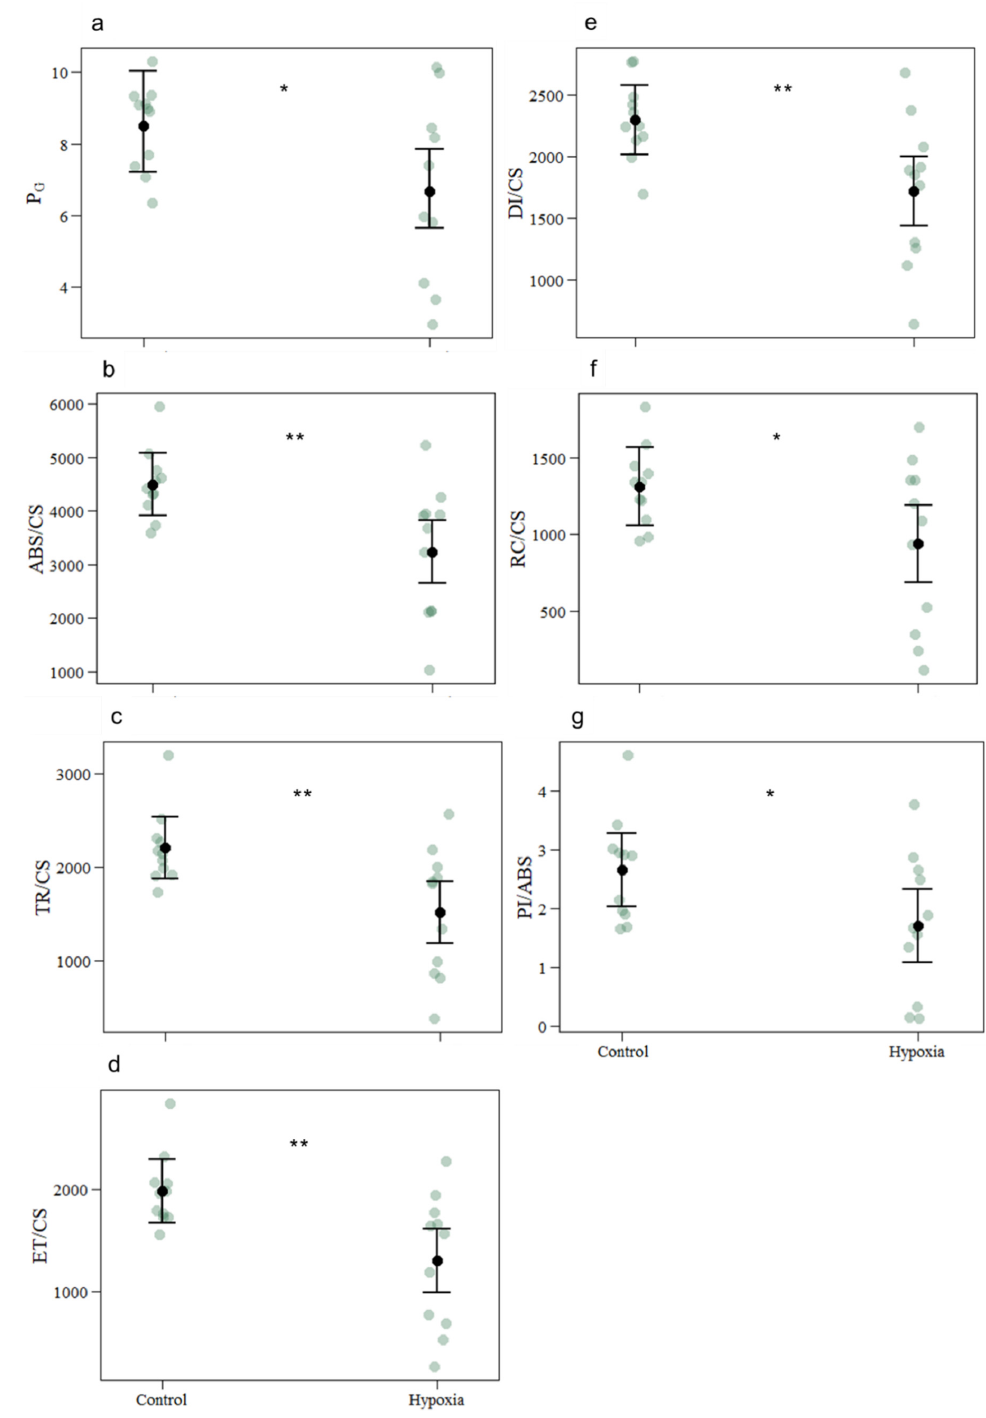
Figure 2. Photobiology-related phenomenological energetic parameters in coral fragments exposed to control and hypoxic conditions. ( a ) grouping probability between the two PS II (P G ); ( b ) absorbed energy flux per cross-section (ABS/CS); ( c ) trapped energy flux per cross-section (TR/CS); ( d ) elec- tron transport energy flux per cross-section (ET/CS); ( e ) dissipated energy flux per cross-section (DI/CS); ( f ) number of oxidized PS II reaction centres (RC/CS); ( g ) performance index (PI/ABS). The values represent mean and standard deviation, asterisks indicate significant differences between the treatment groups at: p < 0.05 (*); p < 0.01 (**) (control n = 11; hypoxia n = 11). The n denotes the number of coral samples assessed in the analysis. CI from the model and each measurement point are